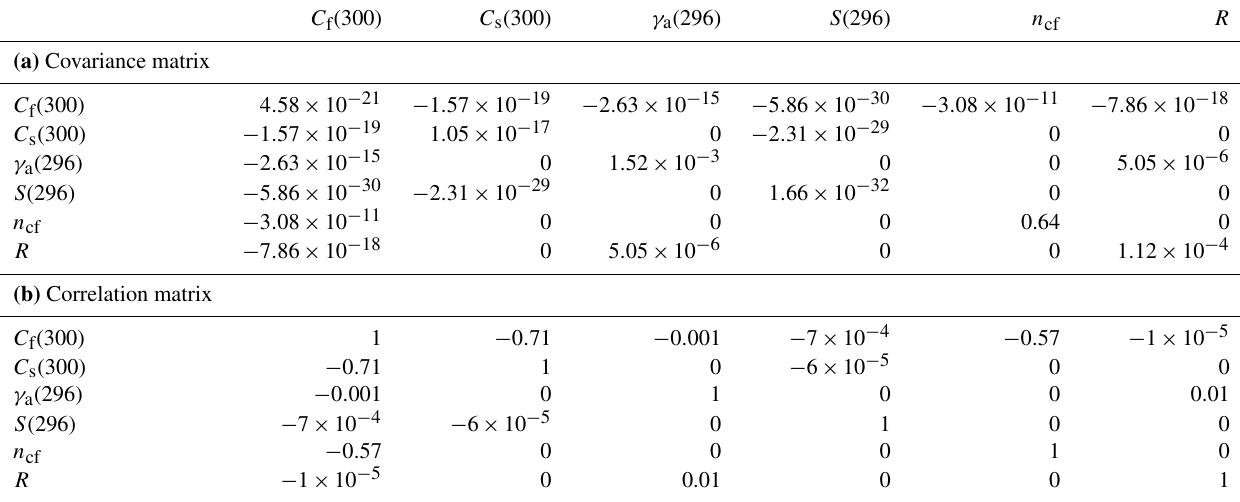
Table 3. Covariance (a) and correlation (b) matrices corresponding to spectroscopic water vapor parameter uncertainties as derived in Sect. 4. Note that C f and C s are evaluated at T 0 = 300K, while γ a and S are evaluated at T 0 =